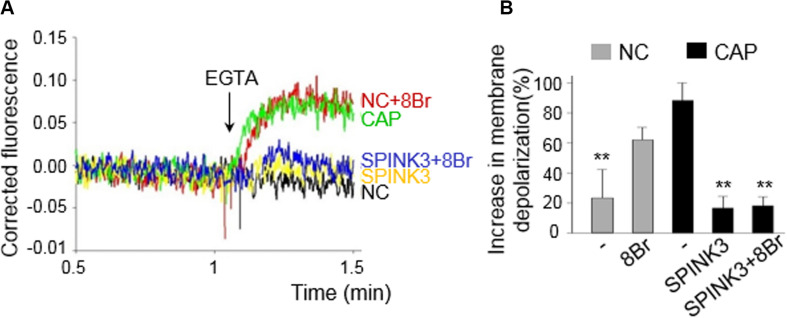
Effect of SPINK3 on Sodium-dependent depolarization induced by EGTA. CatSper opening was indirectly assessed by membrane potential (Em) recordings, and following the magnitude of the EGTA-induced depolarization. Capacitated (CAP) or non-capacitated (NC) sperm were loaded with 1 μM DISC3(5) during Em recordings. (A) Representative traces are shown for all conditions assayed: CAP (green), NC (black), CAP + 13 μM SPINK3 (yellow); NC + 1 mM 8Br-cAMP (red); CAP + 13 μM SPINK3 + 1 mM 8Br-cAMP (blue). (B) The increase in membrane depolarization is expressed as (F - F0)/F0 × 100, where F0 is the mean value before EGTA addition, and F represents the DISC3(5) signal after addition of EGTA. **p < 0.01 with respect to CAP.